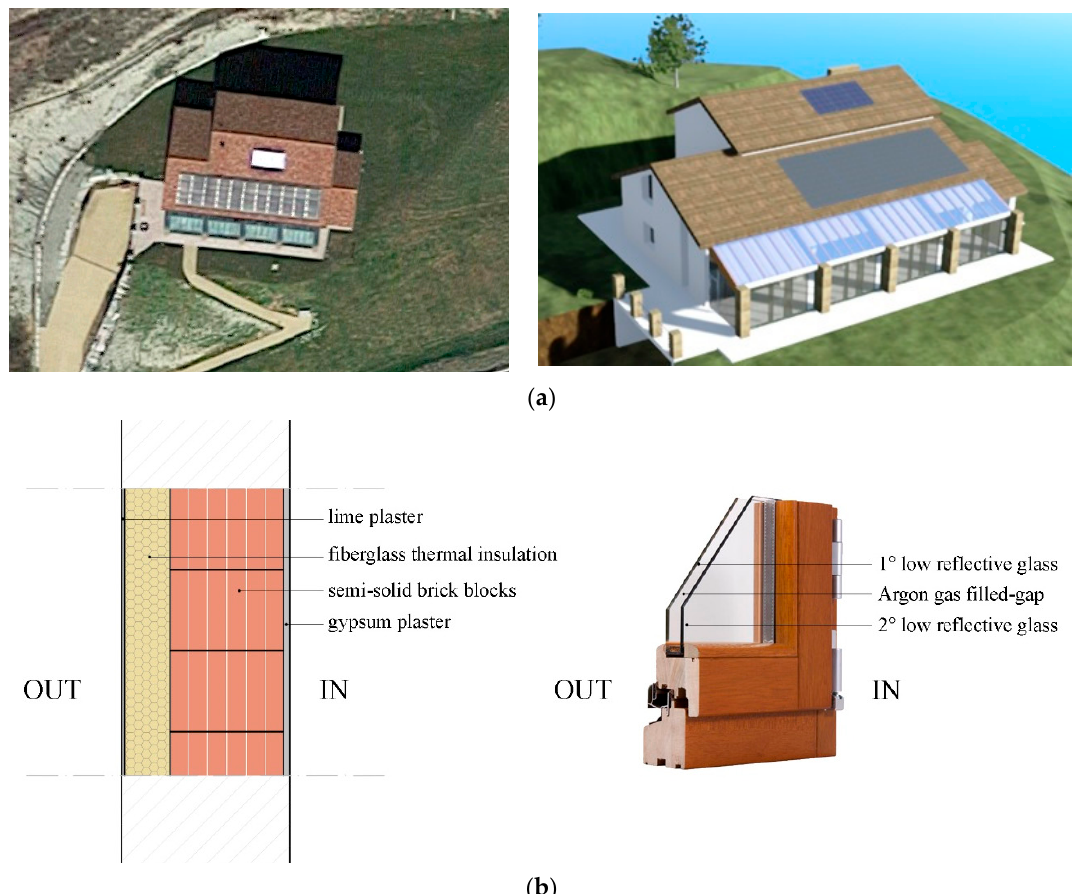
Figure 1. ( a ) Investigated building: overview from Google Maps (left) and lateral view (right); ( b ) stratigraphy of the main building envelope: perimeter wall (left) and low-emission double glazing (right).